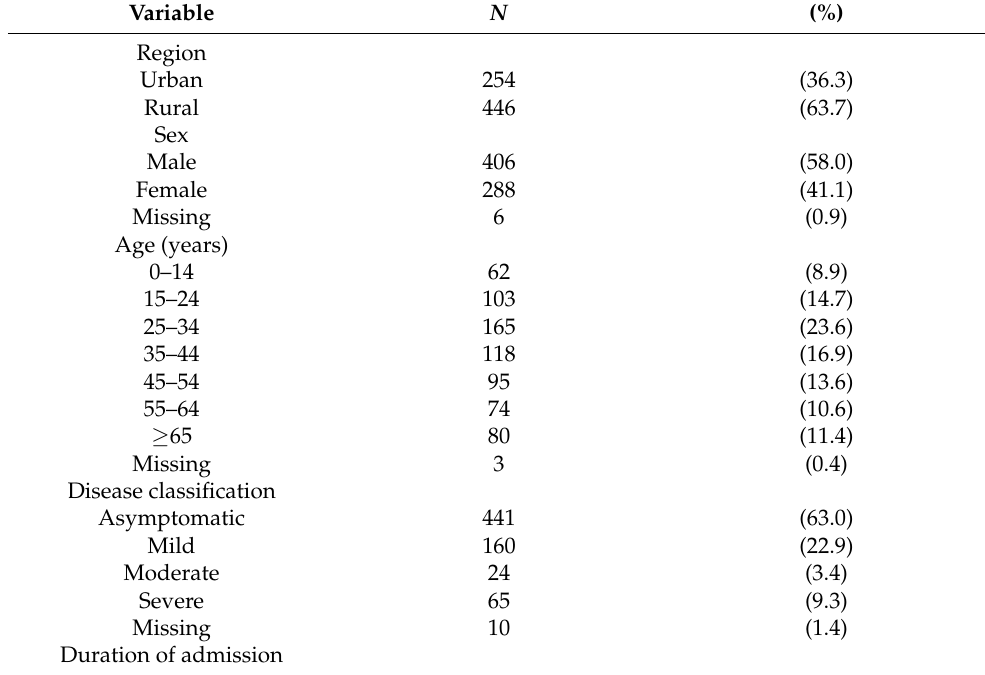
Table 2. Demographic and clinical characteristics of people with confirmed COVID-19 infection admitted in community care and treatment centres in Sierra Leone, March 2020–March 2021 ( N =